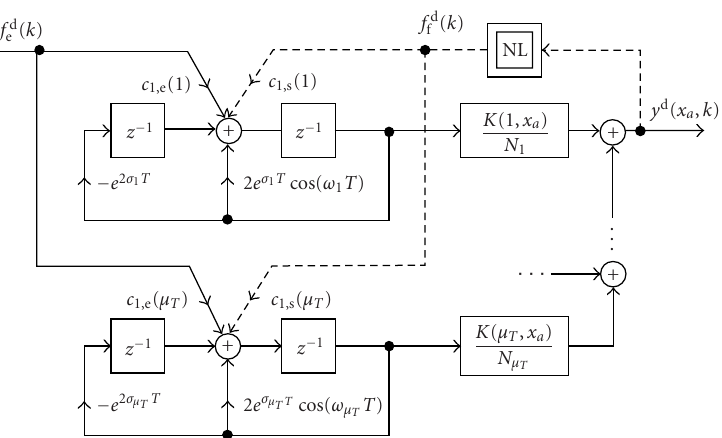
Figure 2: Basic structure of the FTM simulations derived from the linear initial boundary value problem (4), (5), and (6) with several second-order resonators in parallel. Solid lines represent basic linear system, while dashed lines represent extensions for the nonlinear slap force.